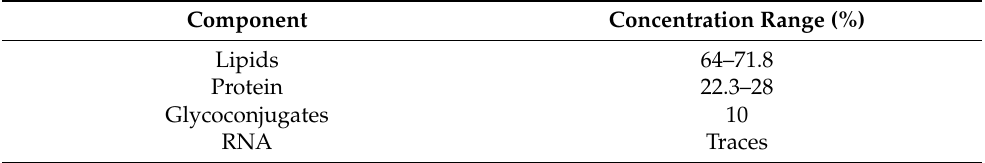
Table 1. General composition of the milk fat globule membrane (MFGM). Data compiled from [10–13].